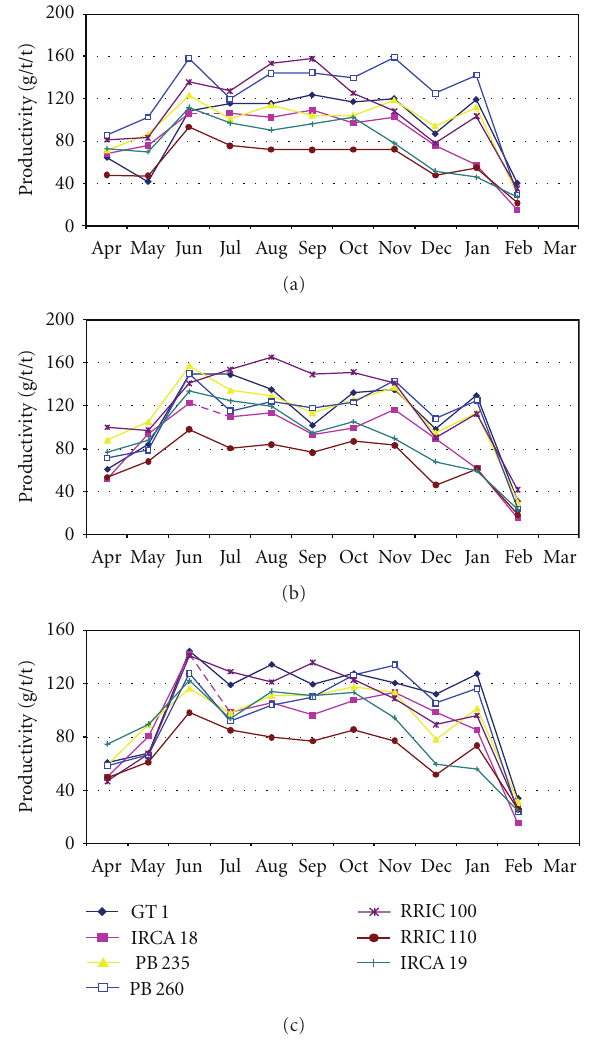
Figure 1: Seasonal variations in yields of the various clones sub- jected to (a) no chemical stimulation, (b) stimulation with 4 rounds Ethephon, and (c) stimulation with 11 rounds Ethephon.